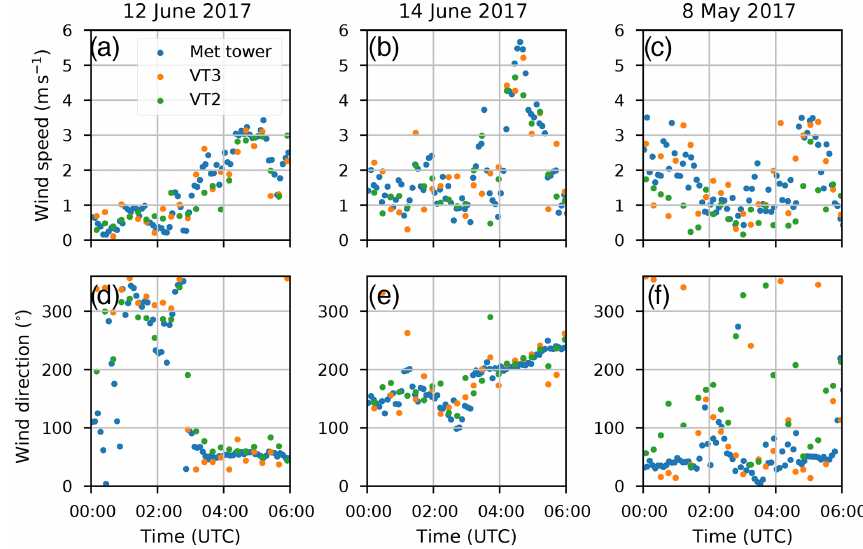
Figure 7. Time series of wind speeds (a–c) and wind directions (d–f) from VT3 (orange points), VT2 (green points), and the 5min averaged data from Tower 25 (blue points) at 100m for the three selected cases.